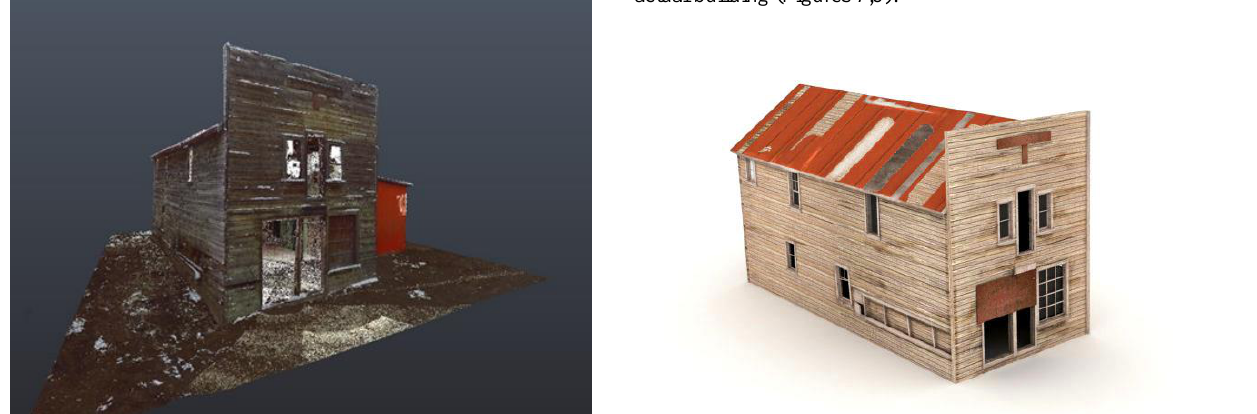
Figure 6: The registered point cloud for the complete building. Source: Peter Dawson